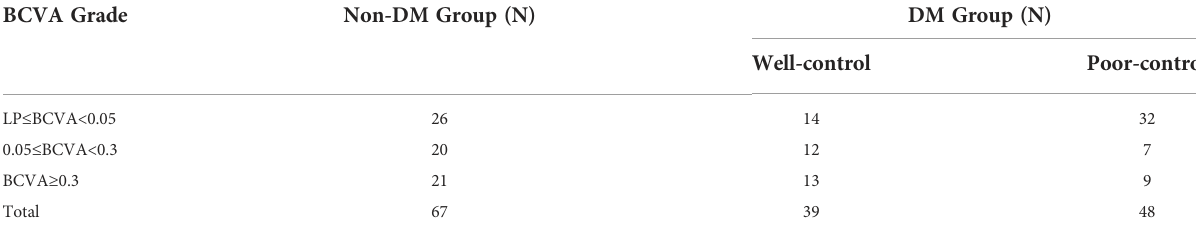
TABLE 4 The BCVA Distribution of AACC Eyes in Study